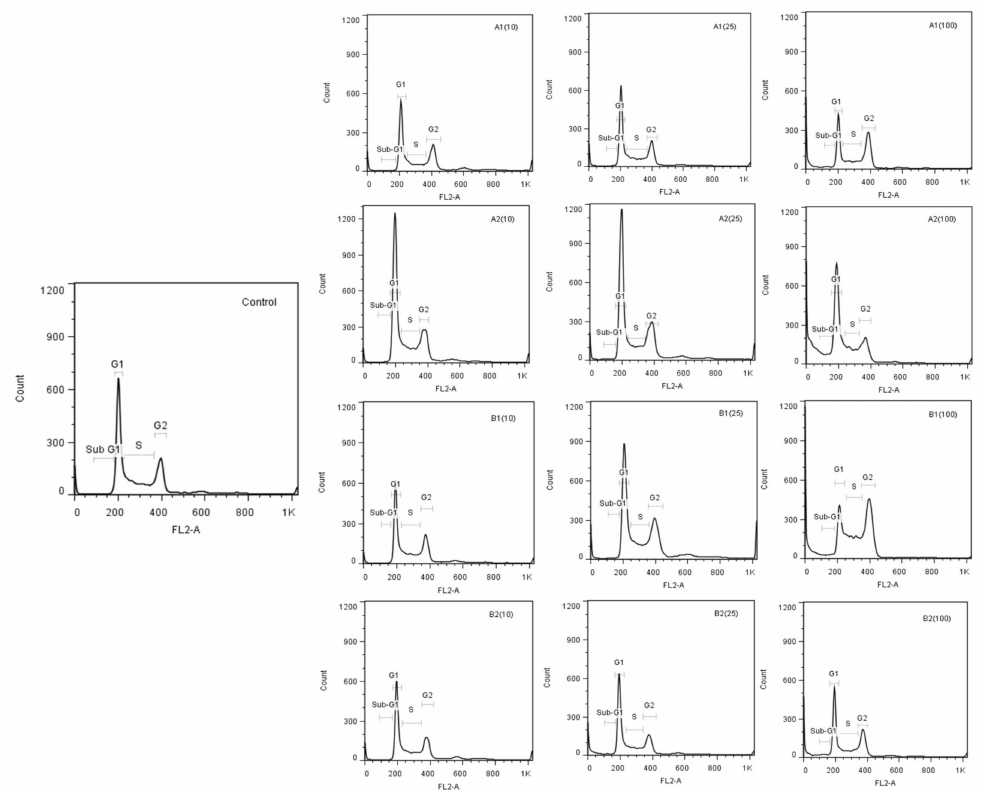
Figure 3. E ff ect of synthesized derivatives on cell cycle alterations in MES-SA-DX5 drug resistant cells. The cells in di ff erent phases of cell cycle were monitored using propidium iodide (PI)-RNase assay by flow cytometry. MES-SA-DX5 cells were seeded in 12-well plates (1 × 10 6 cells / well) and treated with di ff erent concentrations of synthesized compounds for 24 h. The cells were then collected, washed with PBS and fixed with 70% ethanol overnight at –20 ◦ C. After at least 24 h, fixed cells were washed with PBS and subsequently stained with a DNA staining solution containing PI 20 µ g / mL and RNase 200 µ g / mL at room temperature for 30 min in the dark. Twenty thousand cells of each sample were analyzed using a FACS Calibur flow cytometer (BD Biosciences, USA). Representative histograms of cells treated with synthesized compounds are shown. An increase in sub-G1 phase cells could be observed after treatment with A1 , A2 , B1 , and B2